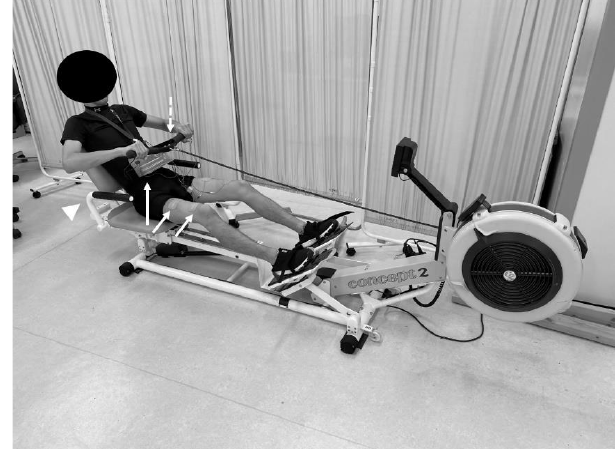
Figure 2. Functional electrical stimulation (FES) rowing machine. A backrest is fixed on the seat (white arrow head). A switch on the handle bar (white dotted arrow) is installed to control the FES (white arrows) timing by the patients themselves.